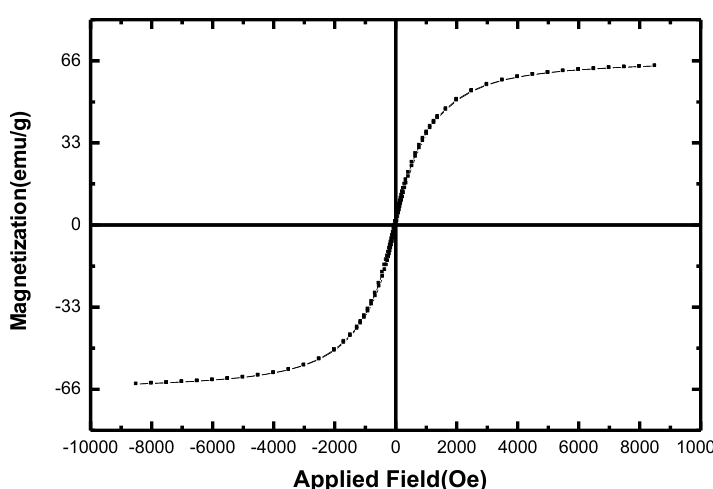
Fig. 8. Room temperature hysteresis loop of Fe